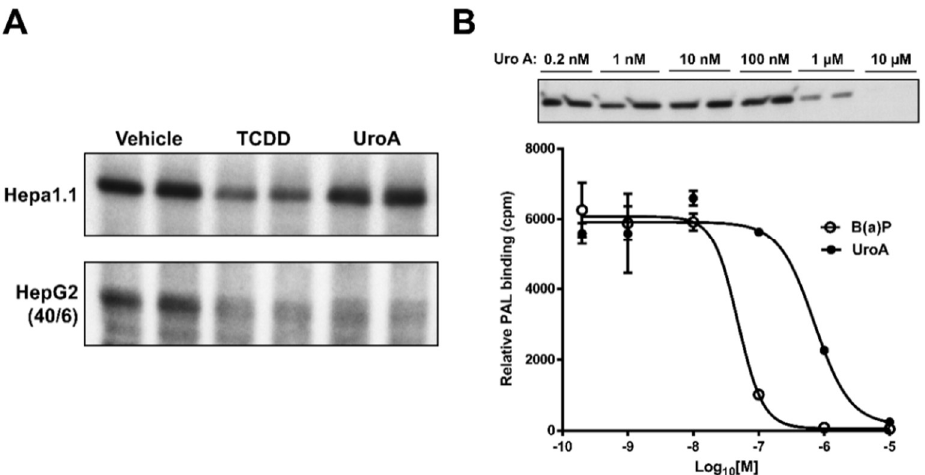
Figure 8. UroA is a direct AHR ligand. Competitive ligand binding assay was performed in ( A ) Hepa1.1 and HepG2 (40/6) cells incubated with the PAL and 10 µM of UroA or TCDD for 1 h, and ( B ) human AHR liver cytosol, in the presence of indicated doses of B(a)P or UroA.